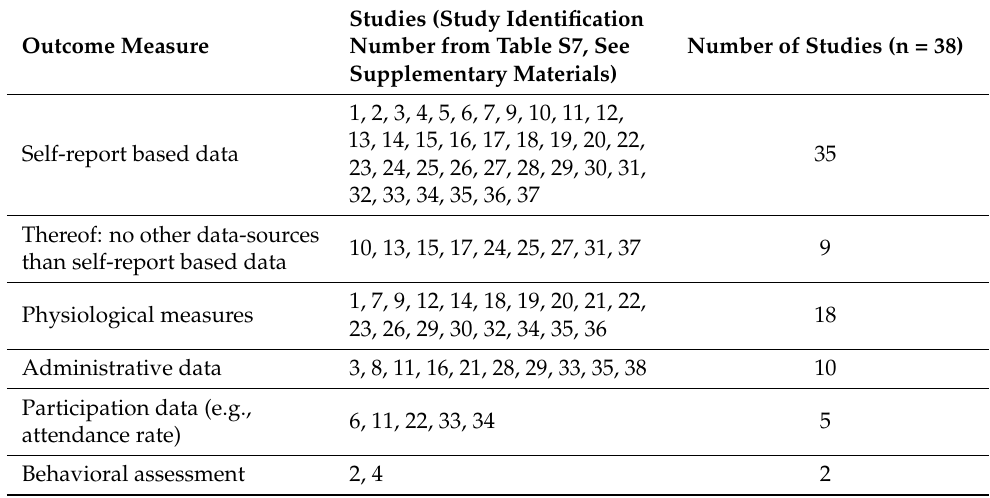
Table 2. Reported outcome measures in the studies including interventions to promote the utilization of physical health care for people with a SMI.